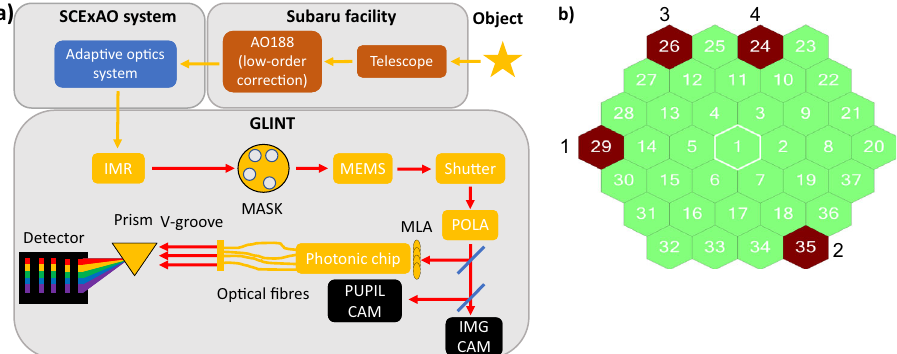
Fig. 1 Global schematic of GLINT and con fi guration of the apertures of the mask. a Global schematic of GLINT and its integration within the Subaru Telescope and SCExAO. Within GLINT itself the sequence of optical systems encountered consists of the image rotator (IMR), a pupil mask, a steerable segmented mirror (MEMS), a shutter and a linear polarising beamsplitter (POLA). The science beam is then injected by a microlens array (MLA) into the photonic chip while the dichroic beamsplitter delivers light to cameras viewing both the image plane and pupil plane. The processed beams coming from the photonic chip are spectrally dispersed in the GLINT spectrograph then imaged on the science detector (C-Red 2). b Diagram of the segmented MEMS mirror with highlighted segments in red matching the pattern of holes in the mask. Segments 29, 35, 26 and 24 are identi fi ed with beams 1, 2, 3 and 4, respectively. The lengths of baselines range from 2.15 m (combination of the beams 3 and 4) to 6.45 m (combination of the beams 2 and